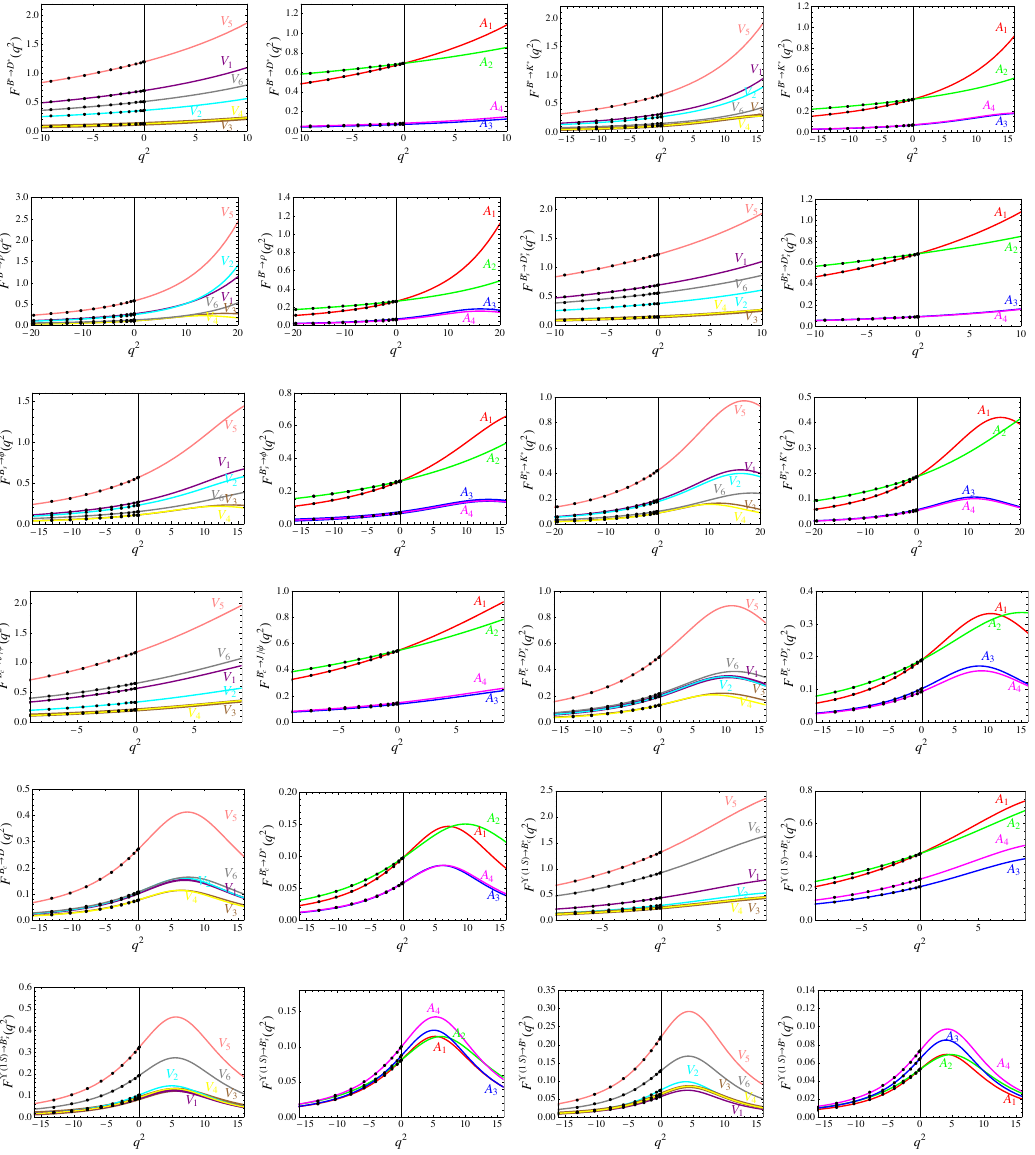
Figure 6 . Same as (cid:12)gure 4 except with the parameterization scheme given by eq. (4.15).